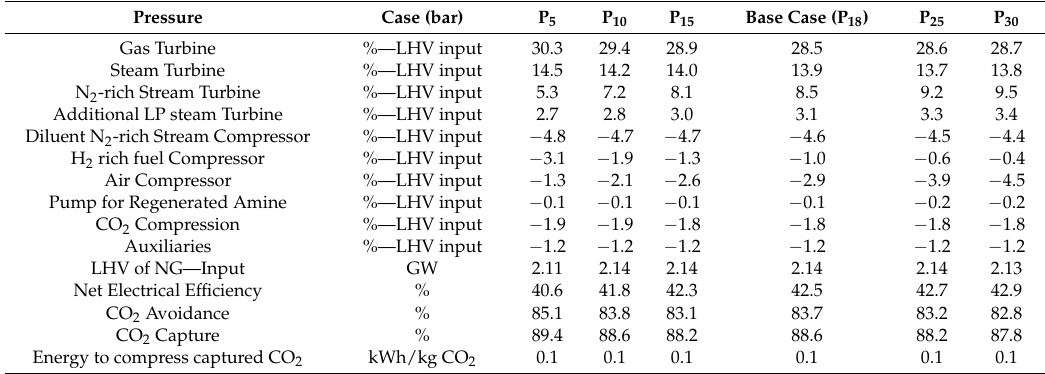
Table 3. Results from analysis of CLR-CC at different design pressures in chemical looping reforming